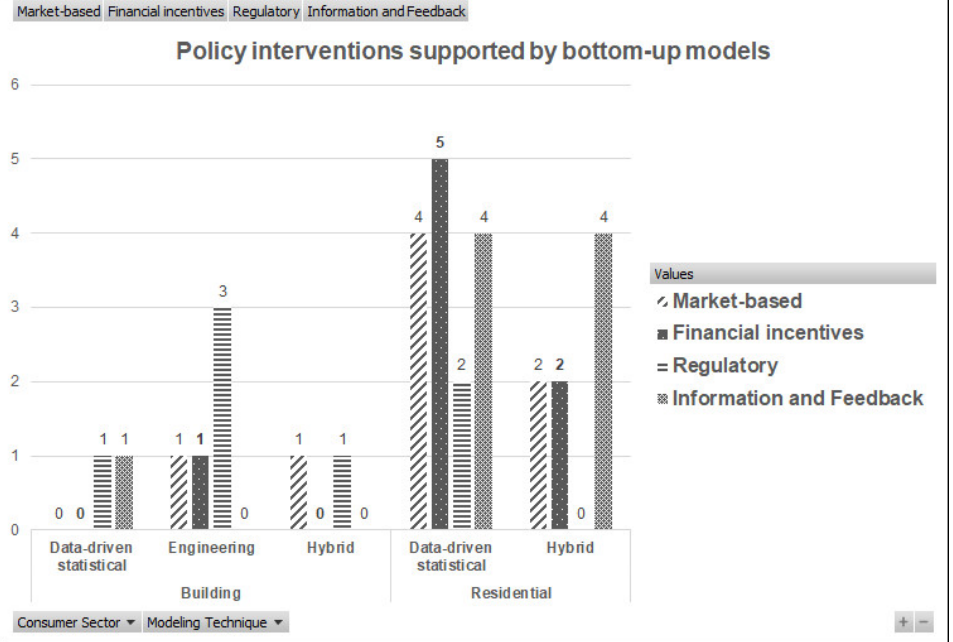
Figure 7. Distribution policy instruments supported by bottom-up